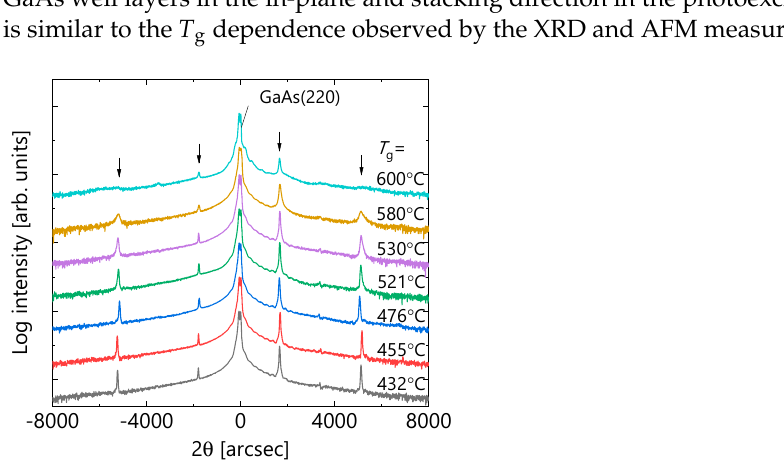
Figure 4. X-ray diffraction (XRD) profiles of θ -2 θ scan at the (220) diffraction for the samples with given T g . The x-axis is the angle relative to the diffraction angle of GaAs. The satellite peaks derived from the periodic structure of multiple quantum wells (MQWs) are indicated by the arrows.